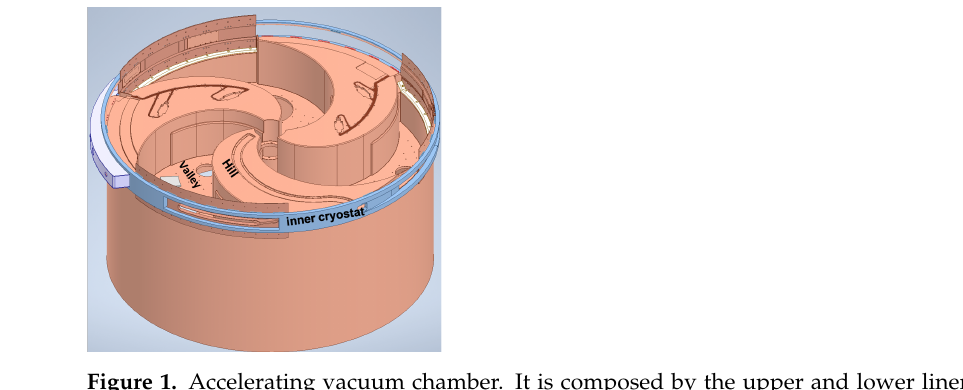
Figure 1. Accelerating vacuum chamber. It is composed by the upper and lower liner (only the inferior one is visible) and the inner part of the cryostat. The RF cavity including the coaxial stem and Dees are installed in the valley of the liner.